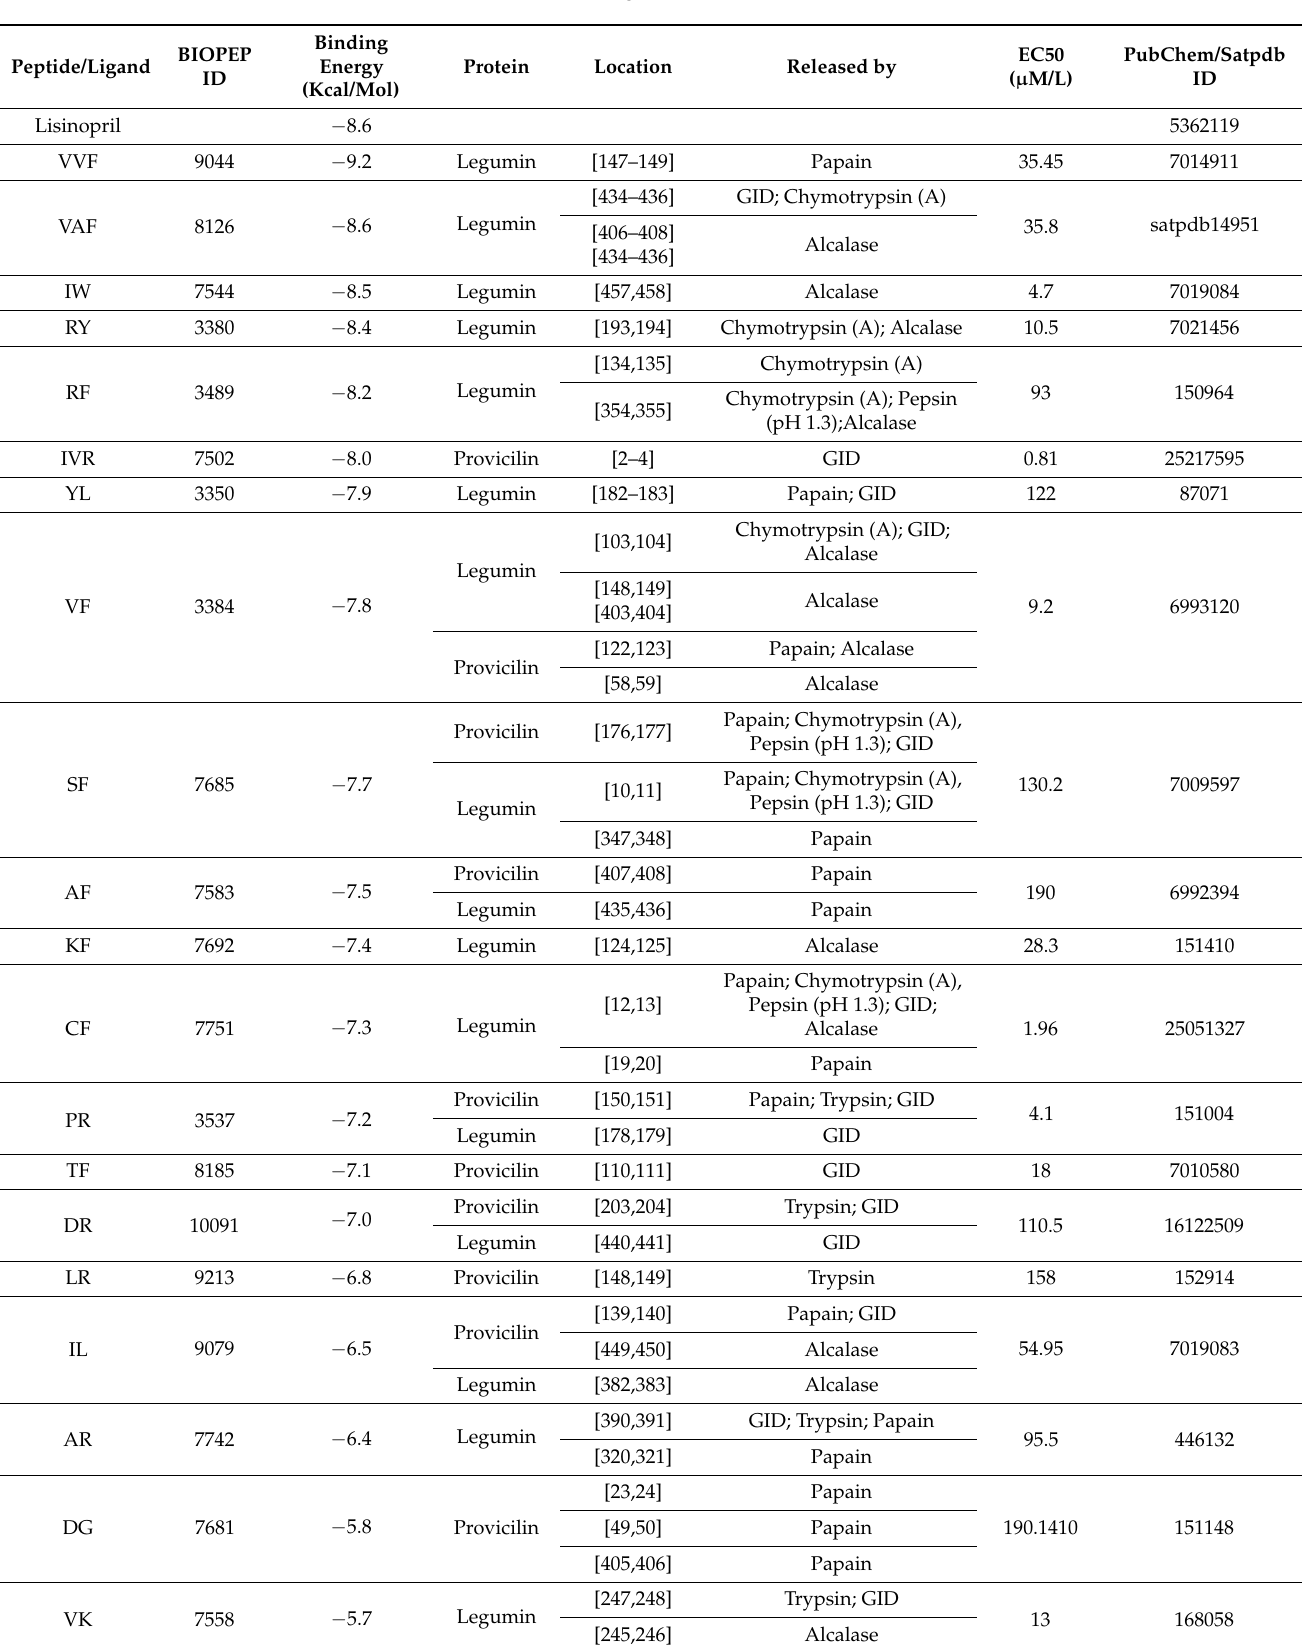
Table 2. The molecular docking results for CP with the active sites of